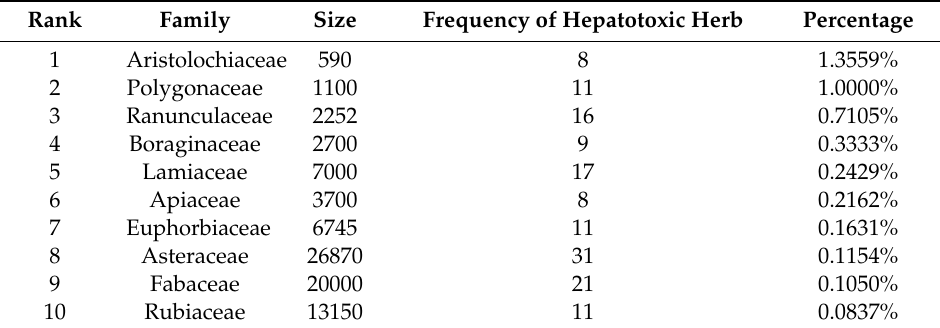
Table 2. Top-10 most productive families of hepatotoxic